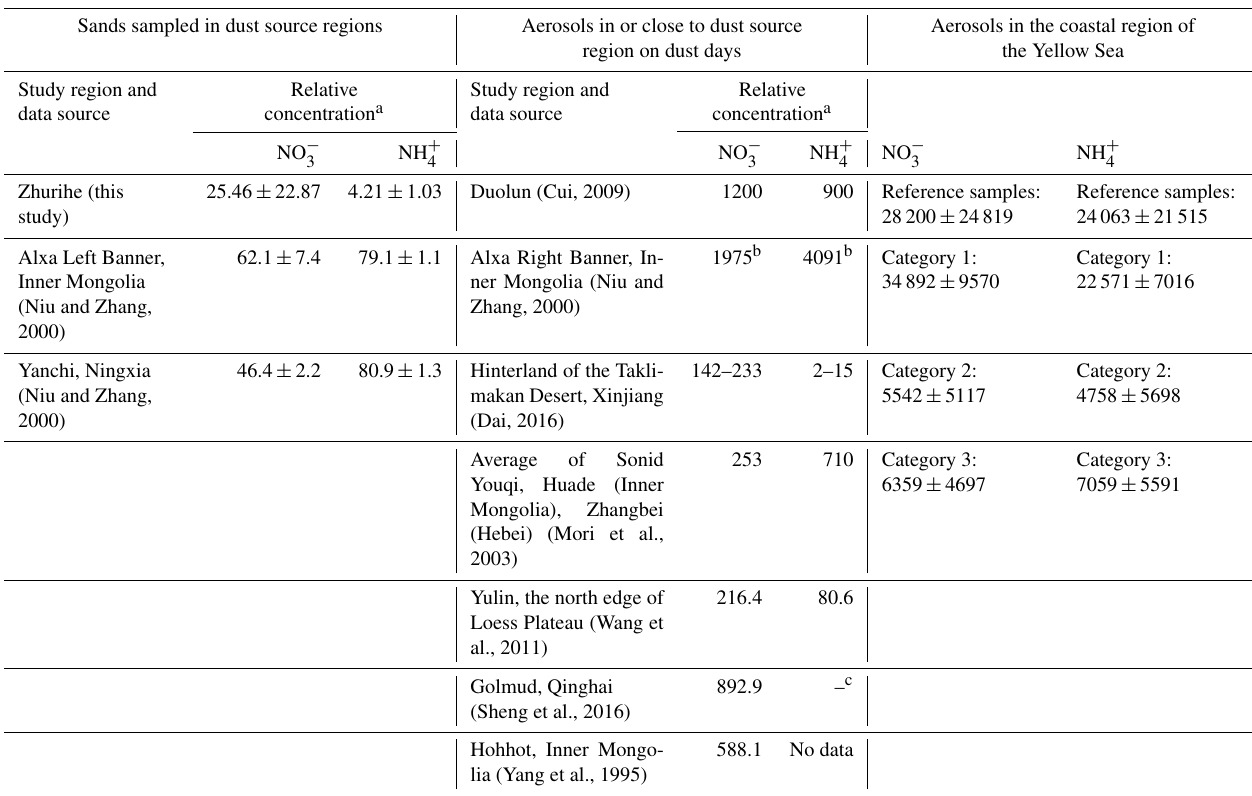
Table 5. Comparison of the NH + µgg − 1